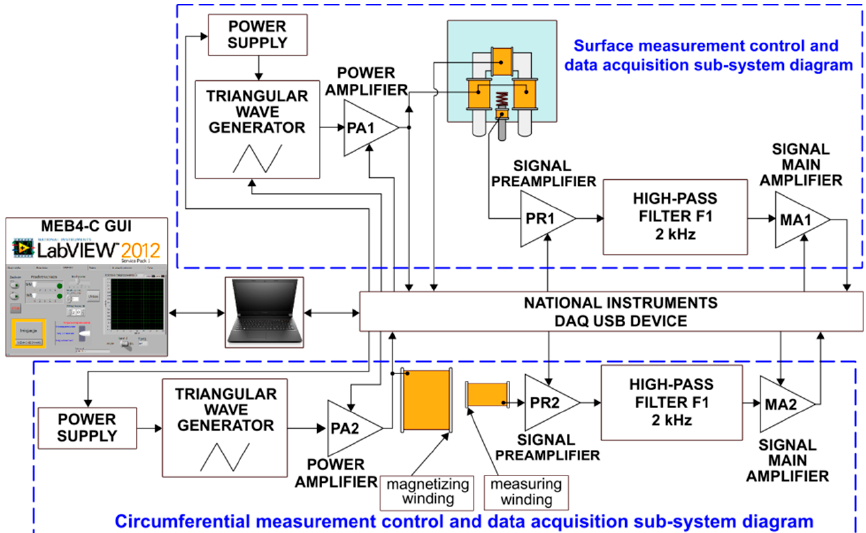
Figure 4. Schematic diagram of the MEB4-C system.